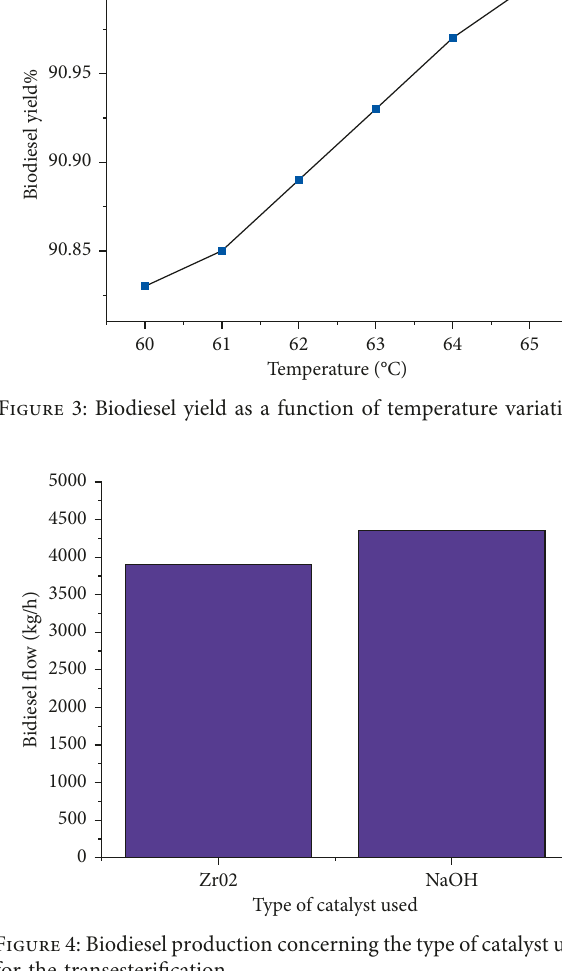
Table 1: Details of plant stream flow pilot used for the base simulation.